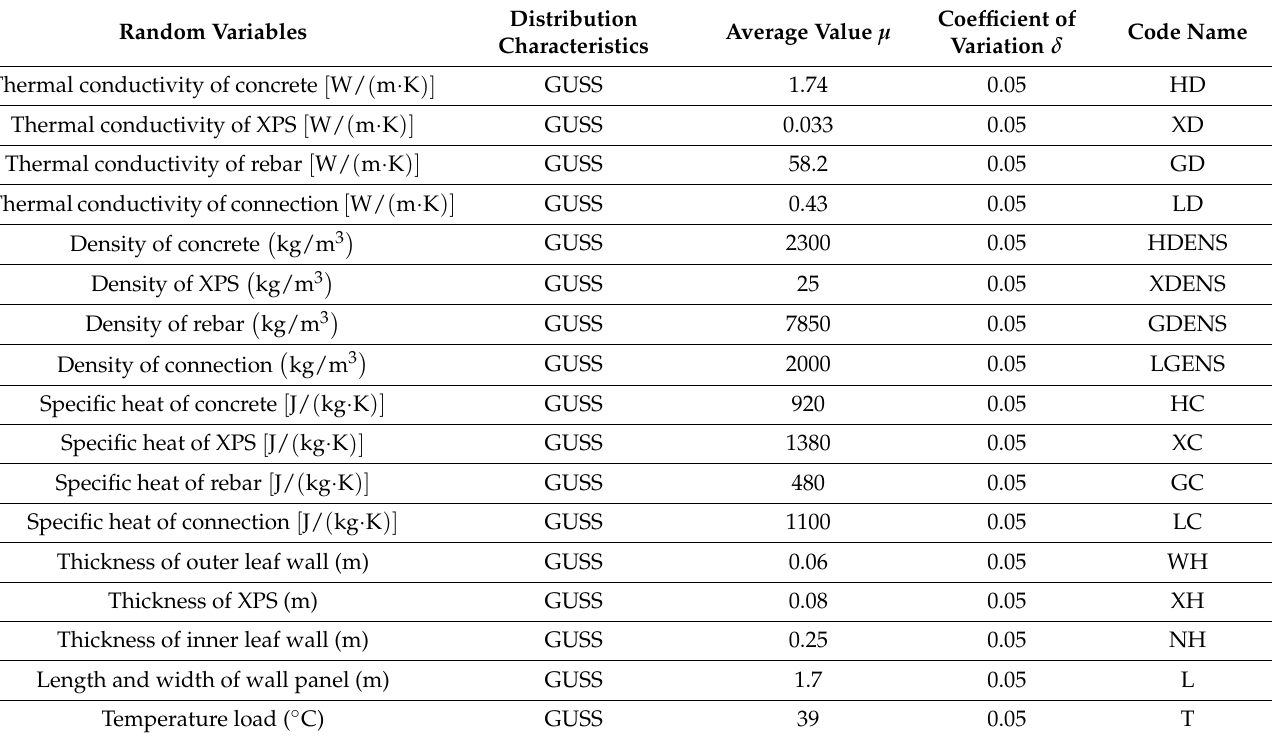
Table 5. Distribution characteristics of random